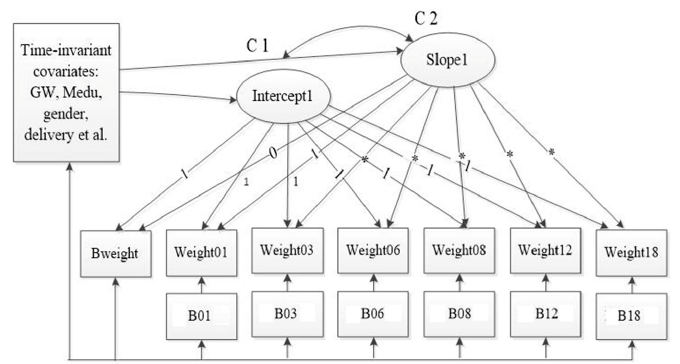
Figure 2. The measurement of LGCM with time-invariant and time-varying covariates for